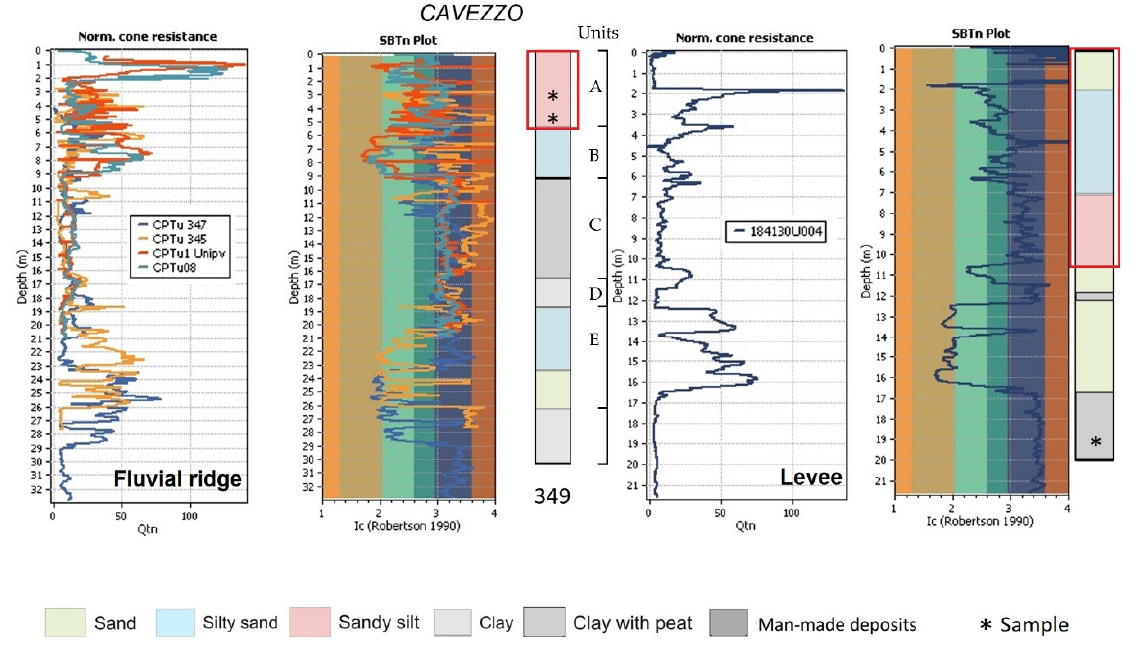
Figure 9. Comparison of normalized cone resistance (Qtn) and Ic versus the representative strati- graphic logs of the borehole for two depositional units, such as fluvial ridge and levee. The red box represents the sandy layers not recognized using the cone penetration tests.